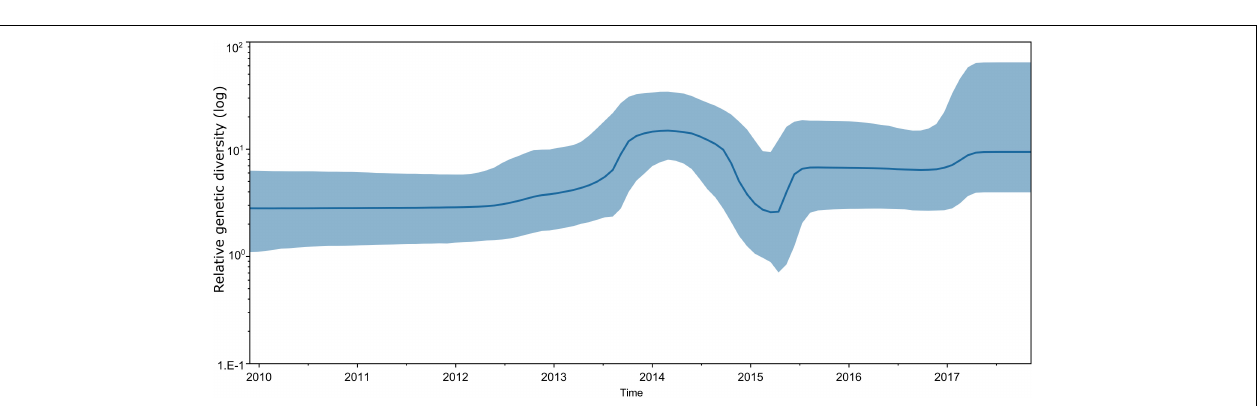
FIGURE 4 | Estimated relative genetic diversity of CVA16 in Vietnam by Bayesian skyline plot using VP1 sequence dataset.